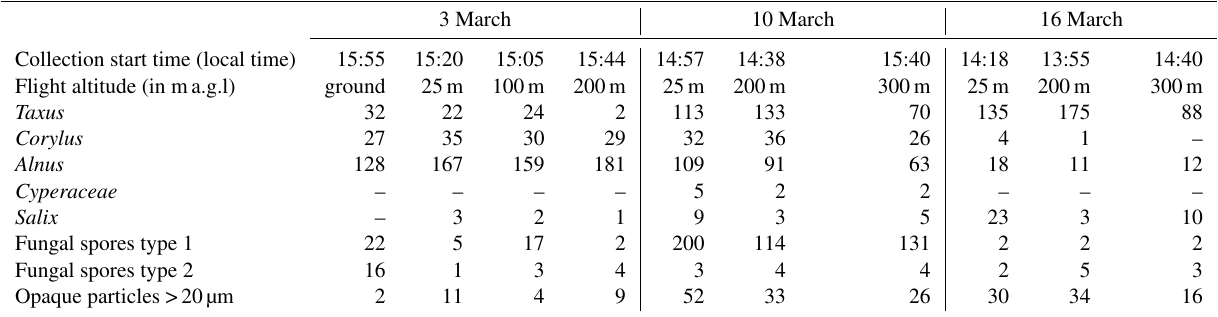
Table 3. Summary of the number of collected particles (from 2 m 3 sampled air) using the new particle collection system (PCS) on board the multicopter UAV during the aerosol particle collection flights carried out in March 2017 (top). In addition, the comparison of these measured values with the forecast data of the Deutscher Polleninformationsdienst (PID) (middle) and the pollen concentrations measured by MeteoSwiss with a commercially available Burkard pollen sampler in Zürich (bottom). Results of the measurements performed at Poltringen Airfield with the newly developed particle collection system mounted on the multicopter